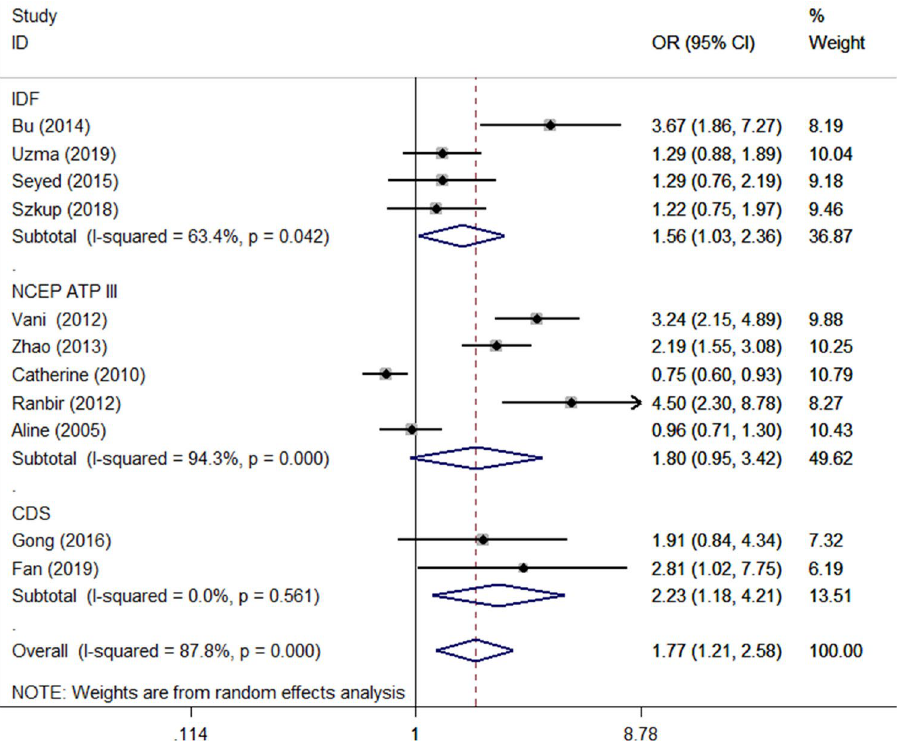
Figure 4. Subgroup analysis stratified by criteria under dominant model. OR odds ratio, CI confidence interval. IDF the International Diabetes Federation, NCEPATP III the National Cholesterol Education Program Adult Treatment Panel III; CDS Chinese Diabetes